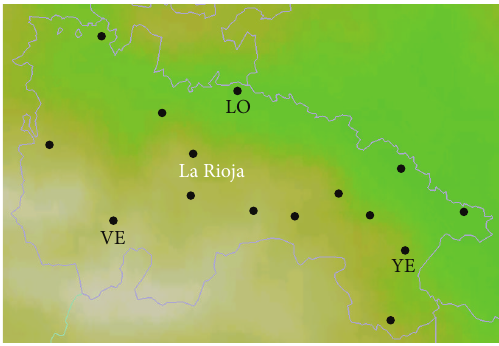
Figure 2: Location map of the weather stations used in the